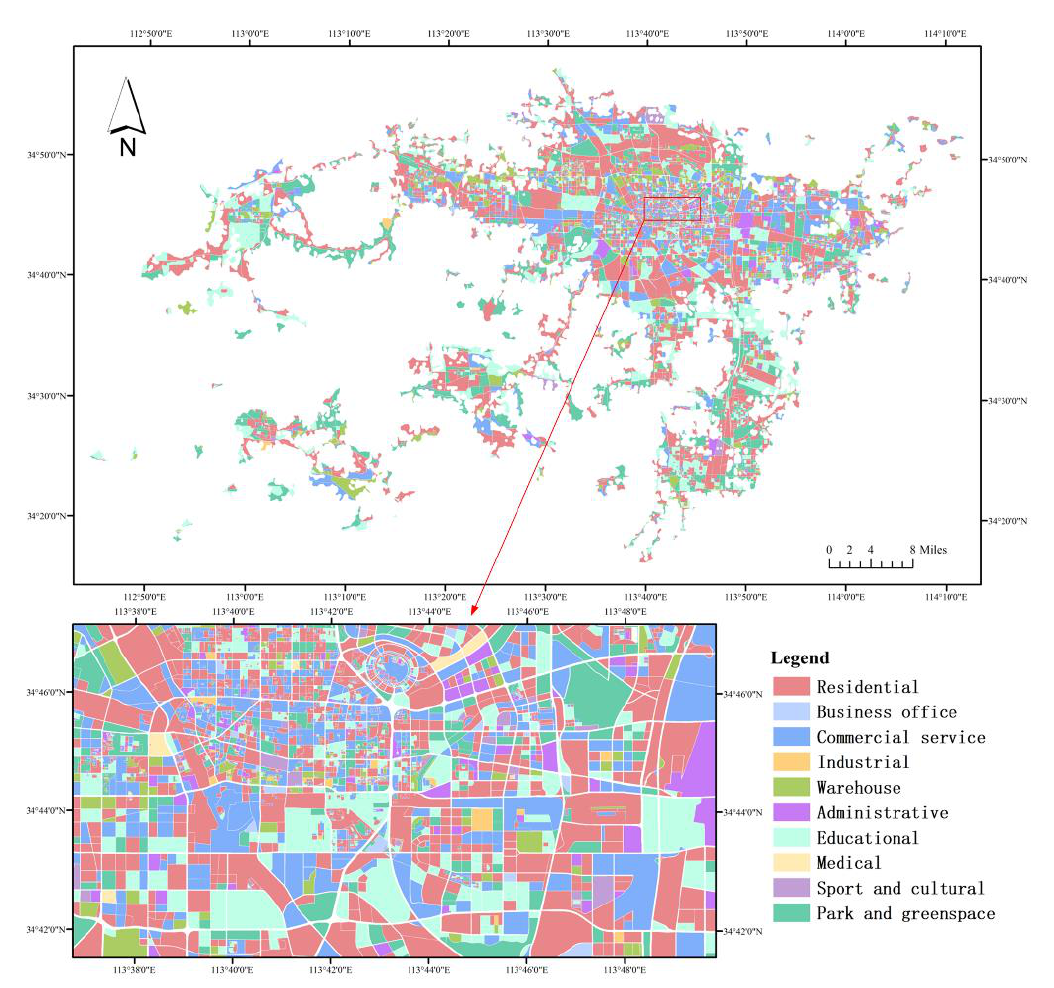
Figure 9. Classification map of Level II features in Zhengzhou.